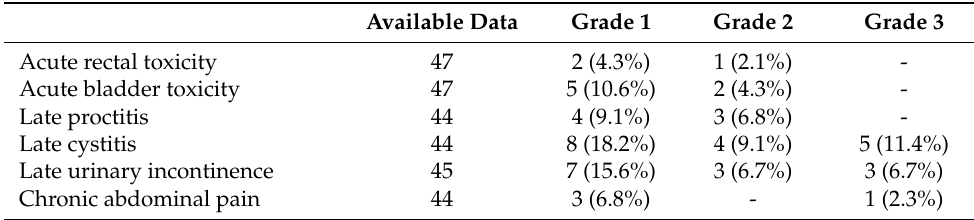
Table 3. Acute and late toxicity associated with stereotactic body radiation therapy.